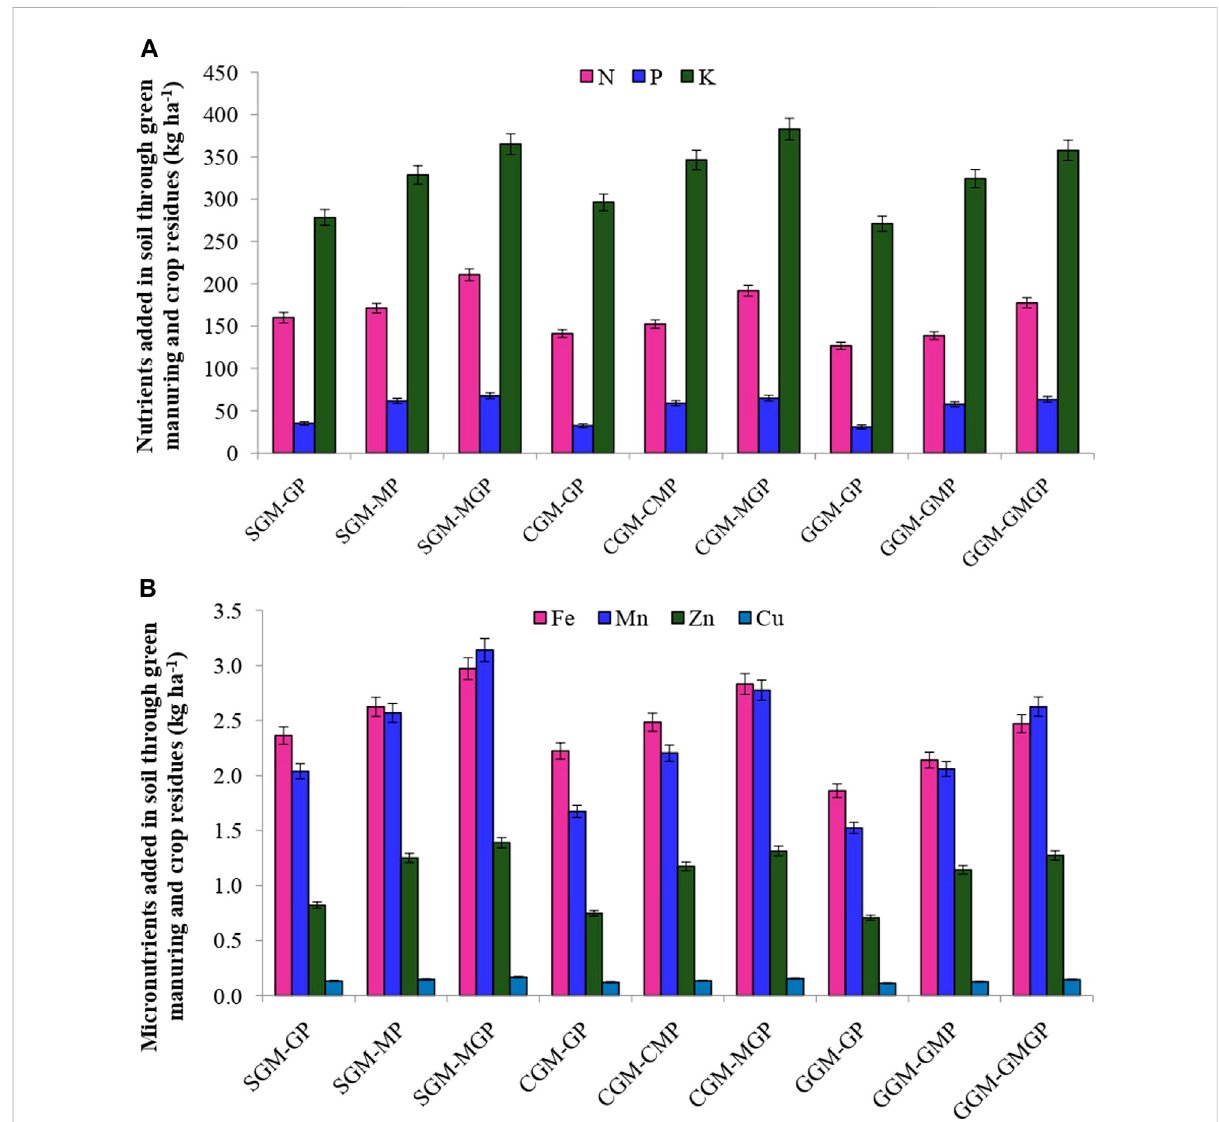
FIGURE 1 Nutrient input (A) macronutrients (N, P, K: Available nitrogen, phosphorus, and potassium, respectively), (B) micronutrients (Fe, Mn, Zn, Cu; DTPA-extractable soil micronutrients iron, manganese, zinc, and copper, years of experimentation. GGm: greengram green manuring, CGM: cowpea green manuring, SGM: sesbania green manuring, GP: groundnut – pea, MP: maize + groundnut – pea. Vertical bar (both way) represents the standard error of mean (p <